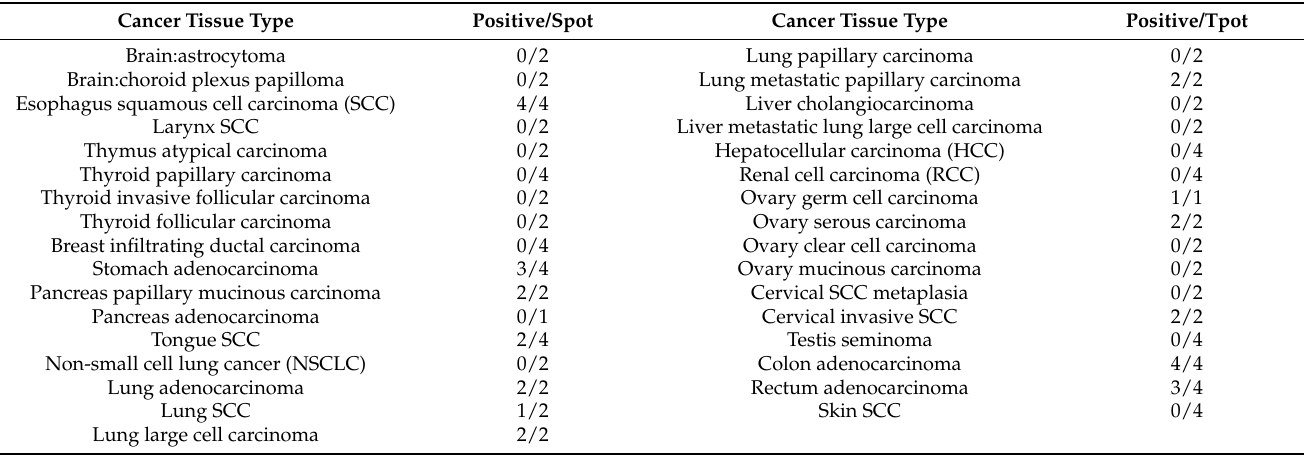
Figure 2. NEO-201 IHC of tumor tissue microarrays. Immunohistochemistry peroxidase staining of NEO-201 mAb (h16C3) and commercial CEACAM 5/6 antibodies in ( A ) colon cancer and normal colon tissue, ( B ) pancreatic cancer and normal pancreas tissue, and ( C ) lung cancer and normal lung tissue. All images were obtained at 100X. Table 1. NEO-201 IHC of tumor tissue